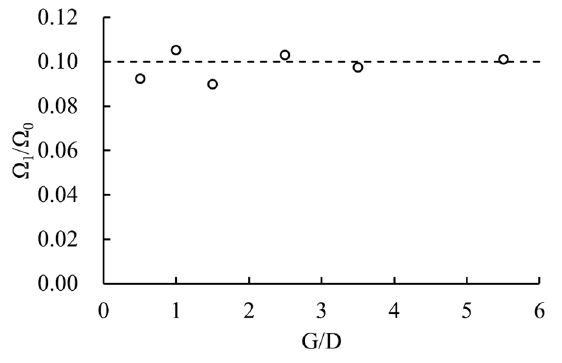
Figure 9. Relationship between Ω (cid:2869) Ω (cid:2868) ⁄ and G / D in the vortex street fl ow pa tt